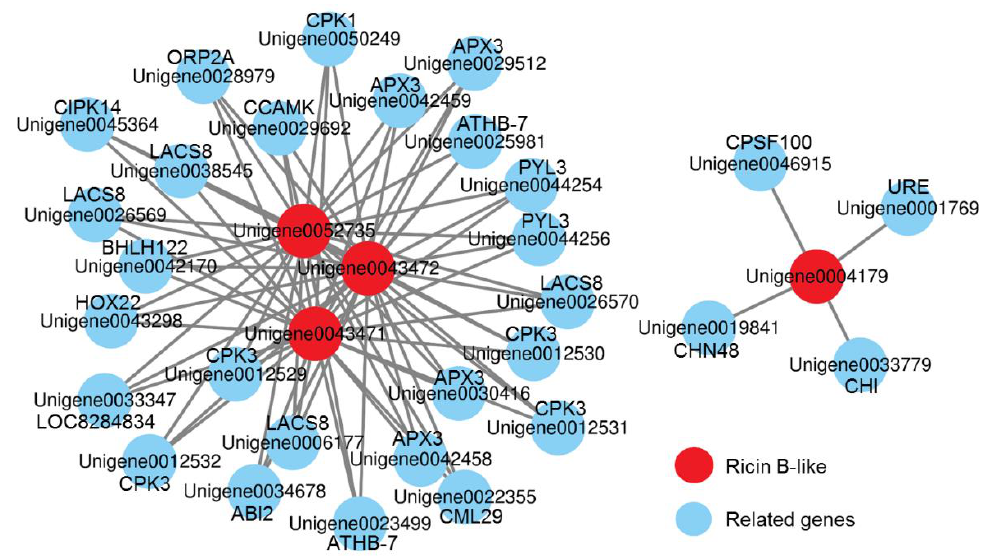
Figure 6. Transcriptional regulatory network of RIP genes in P. volubilis